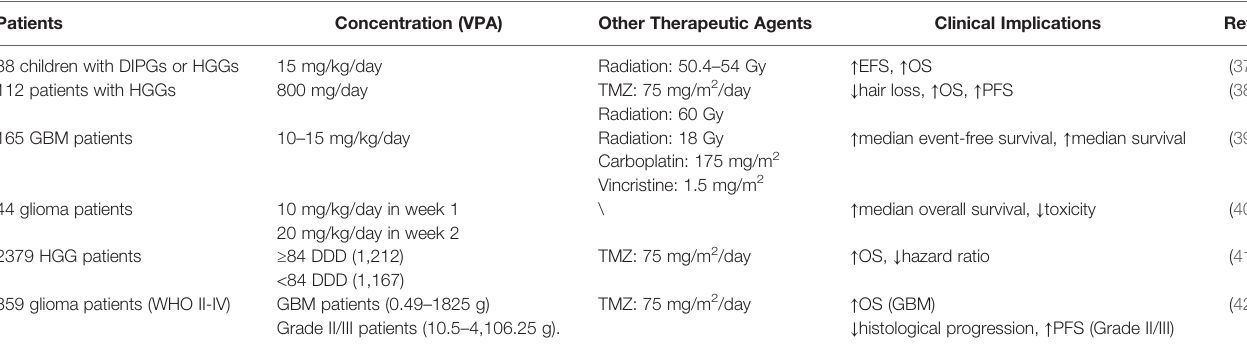
TABLE 3 | Clinical implications of VPA in glioma patients. Patients Concentration (VPA) Other Therapeutic Agents Clinical Implications